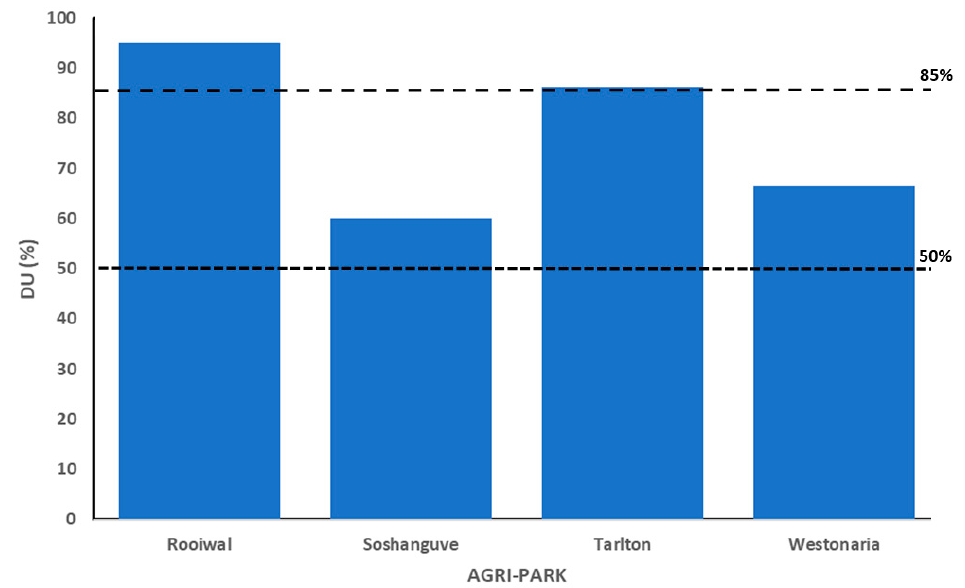
Figure 4. Comparison of distribution uniformities for four Agri-parks in Gauteng province, namely Rooiwal, Soshanguve, Tarlton, and Westonaria.